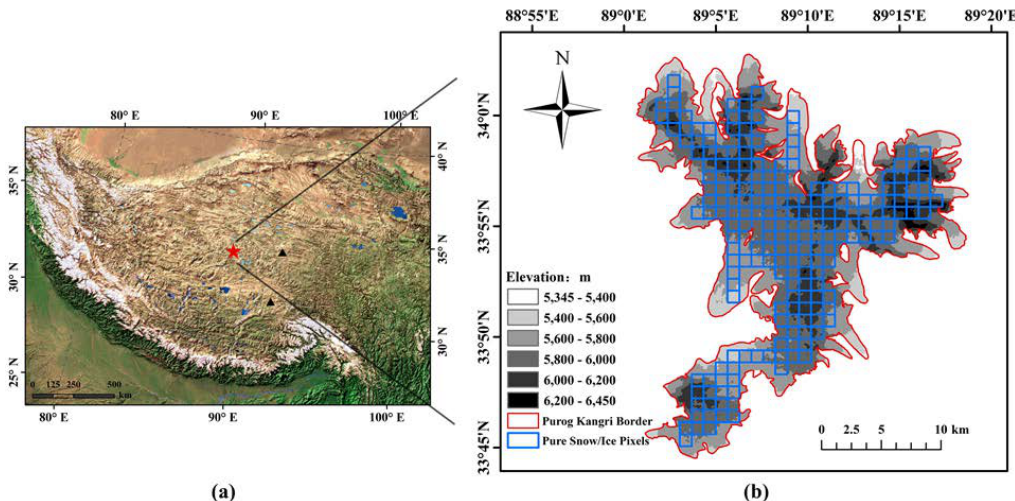
Figure 1. ( a ) Location of the Purog Kangri ice field (red star) and two weather stations (black triangles) and ( b ) extent of the Purog Kangri ice field. Blue grids denote MODIS (Moderate Resolution Imaging Spectroradiometer) LST (land surface temperature) pixels with underlying surface covered purely by snow/ice.